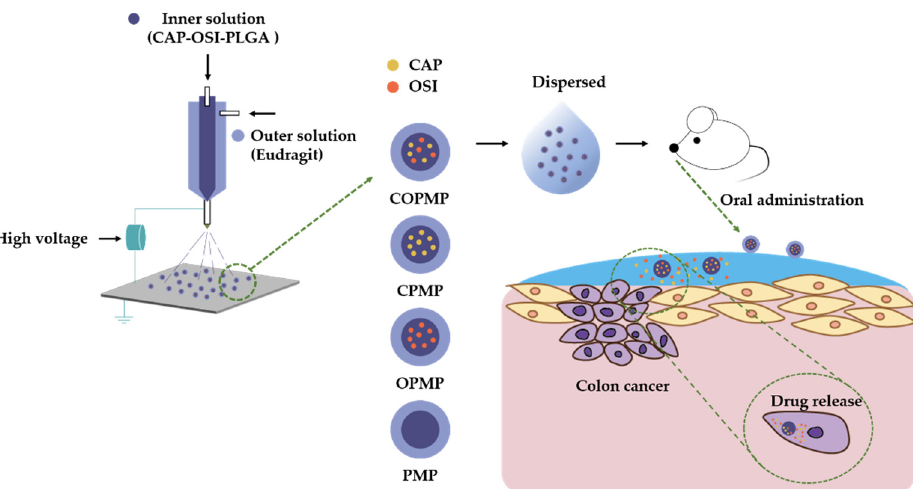
Figure 1. Illustration of COPMP: preparation of the core–shell microparticle by coaxial electrospray and treatment against colon cancer via oral administration. COPMP, CPMP, OPMP, and PMP refer to the inner layers of microparticles with CAP-OSI-PLGA, CAP-PLGA, OSI-PLGA, and PLGA alone, respectively, and likewise for the outer layers.